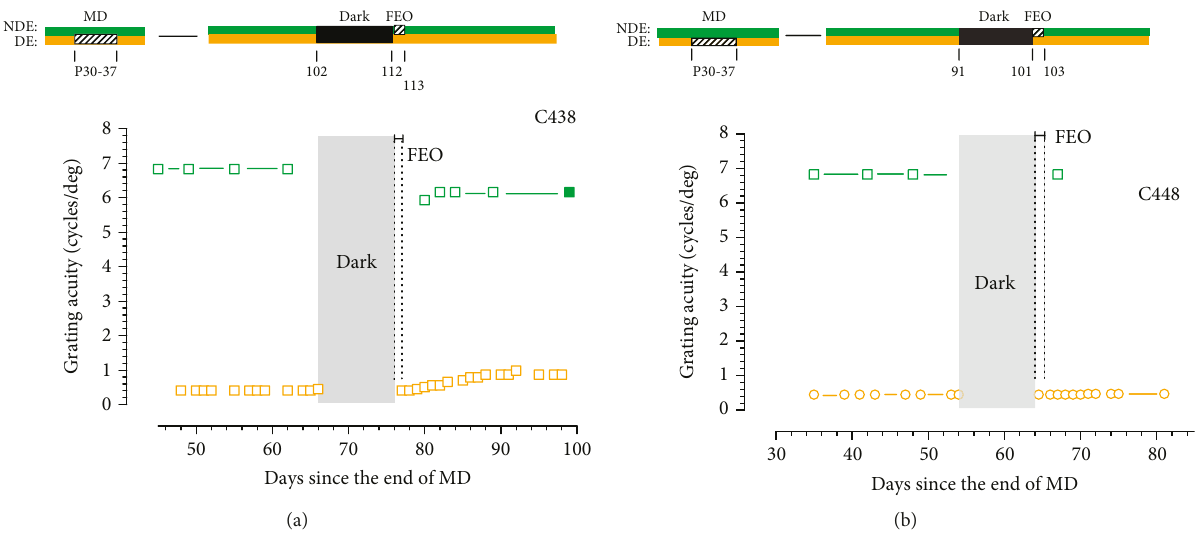
Figure 7: The grating acuity of the deprived eye acuity (orange symbols) and the binocular or nondeprived eye acuity (green symbols) of two monocularly deprived kittens C438 (a) and C448 (b) surrounding 10 days of total darkness followed immediately by a 1-day period of fellow eye occlusion (FEO). The brief period of FEO e ff ectively blocked any improvement of the acuity of the deprived eye following the period of darkness.